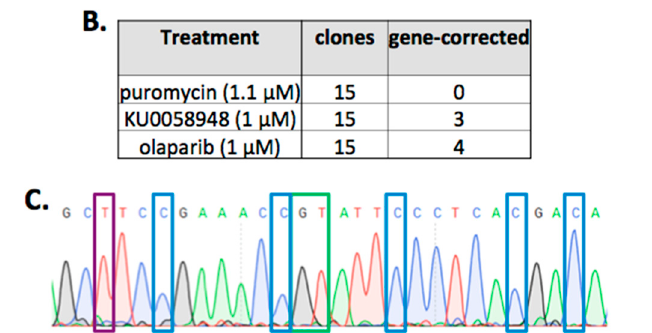
Figure 3. FANCD1 selection and clonal derivation. ( A ) Screening of sense and anti-sense ODN treated cells. PCR with primers that bracket exon 8 (shown as black arrows in Figure 2A were used to amplify the locus (green arrow, 453 bp) followed by Hind III digest. HDR results in a Hind III site that results in ~200 bp fragments (red arrows); ( B ) Clonal isolation. Limiting dilution cloning was performed and the individual clones were screened for HDR. Selection treatment is shown at left, middle panel indicates the number of clones, and right panel shows the frequency of HDR observed in the clones. ( C ) Corrected FANCD1 locus. A representative Sanger sequencing chromatogram is shown for clones that underwent HDR. The blue boxes are the introduced silent polymorphisms that make the modified locus resistant to nuclease re-targeting. The purple box shows the Hind III site, and the GT dinucleotide that corrects the gene is within the green box.